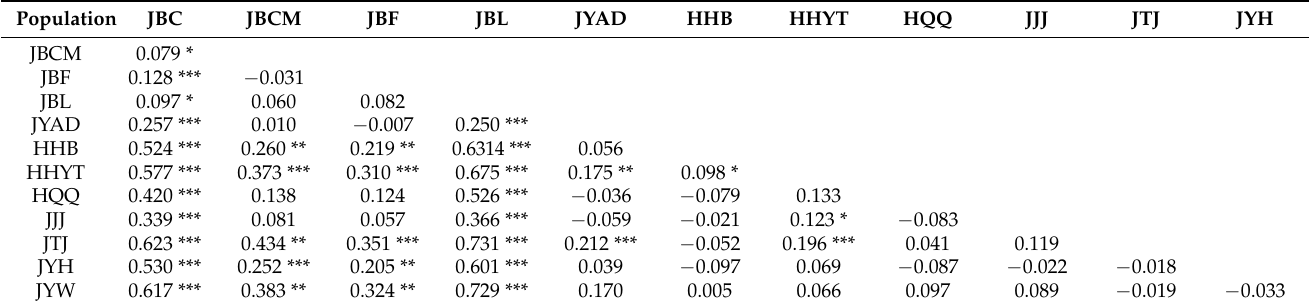
Table 5. Pairwise F ST values among 12 populations of Cylindrocarpon -like isolates.